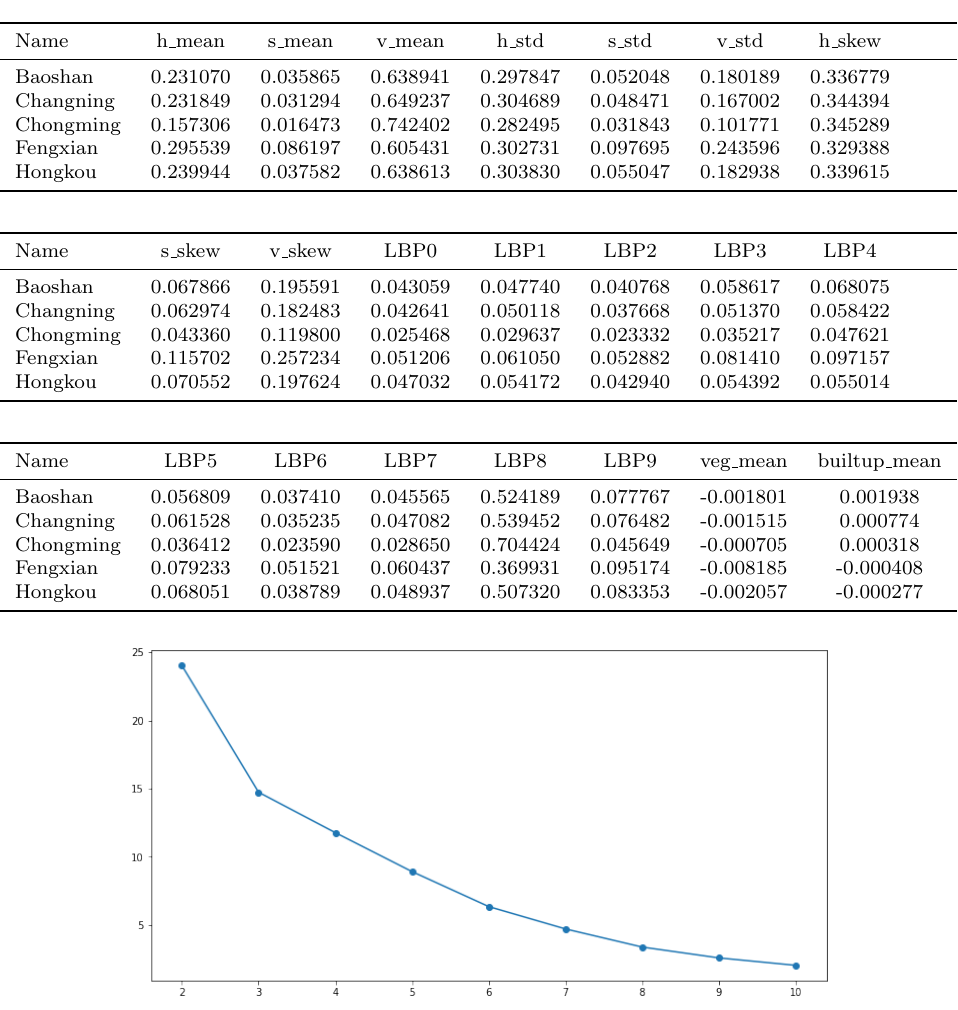
Table 12: Four types of features (21 in total) identified in 2019